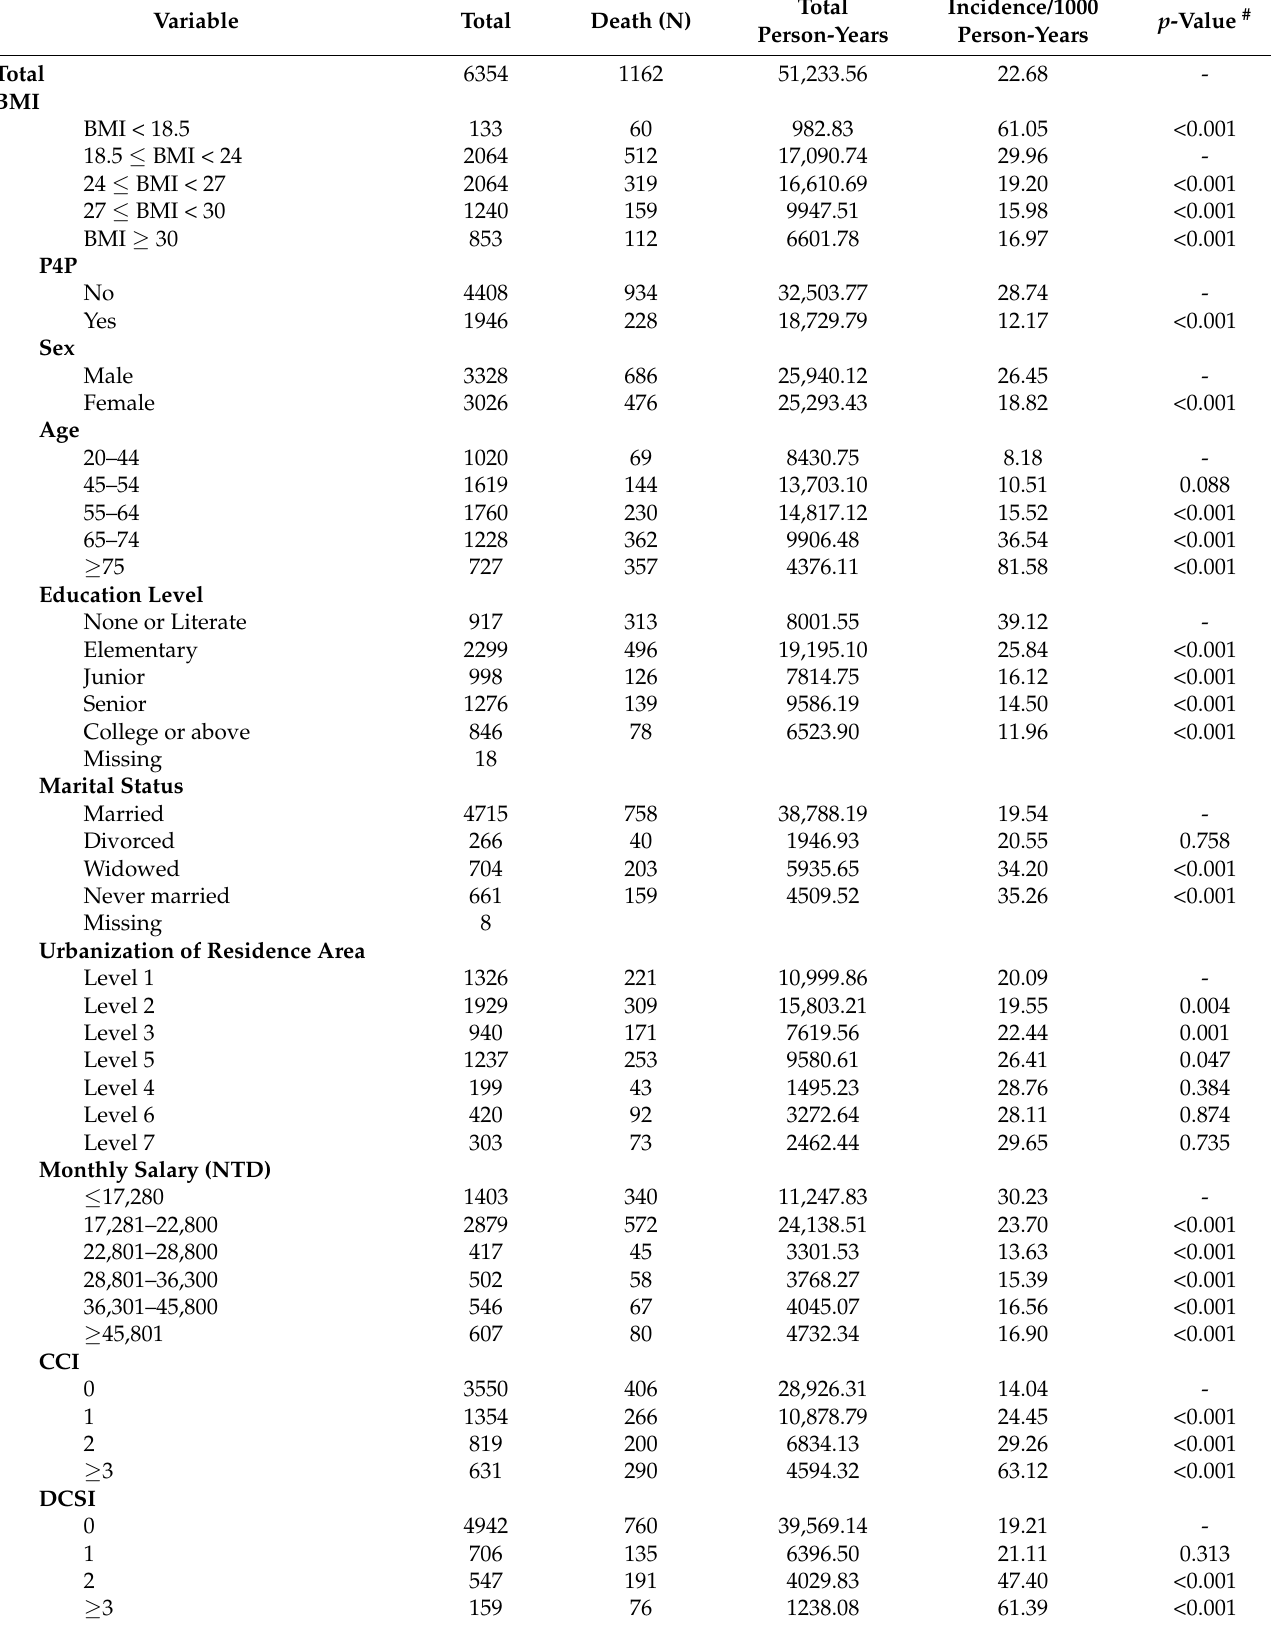
Table 2. The mortality rate of diabetic per 1000